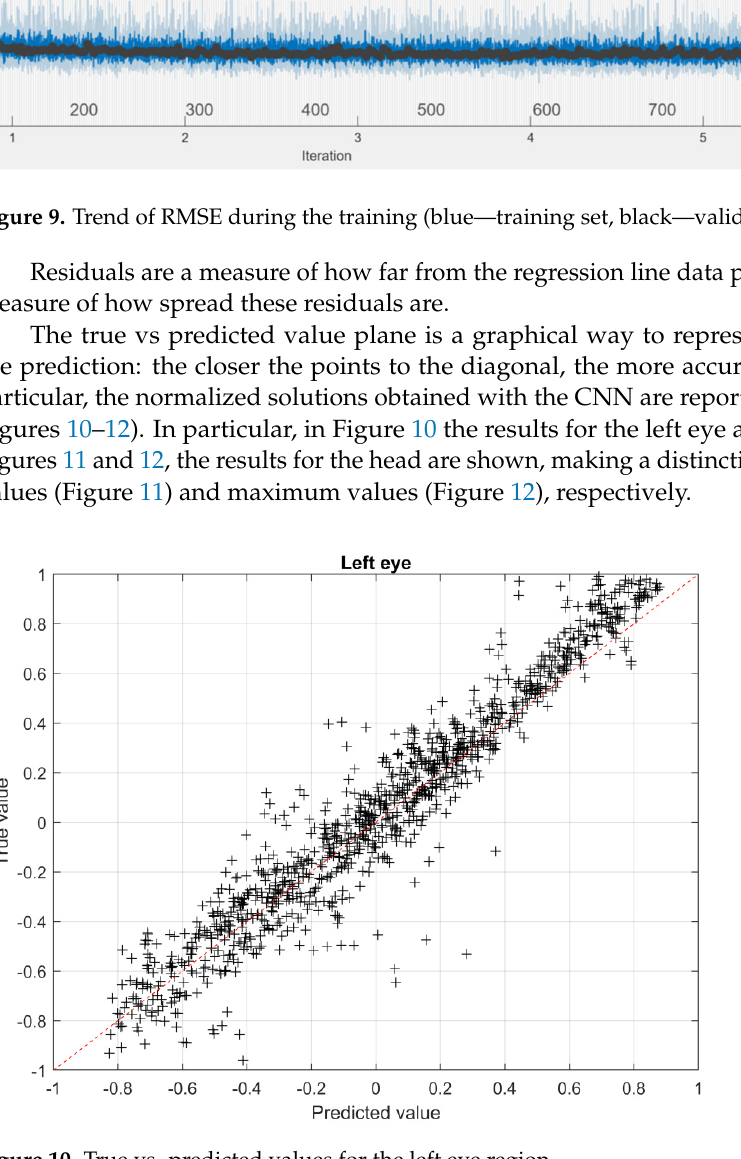
Figure 10. True vs. predicted values for the left eye region.